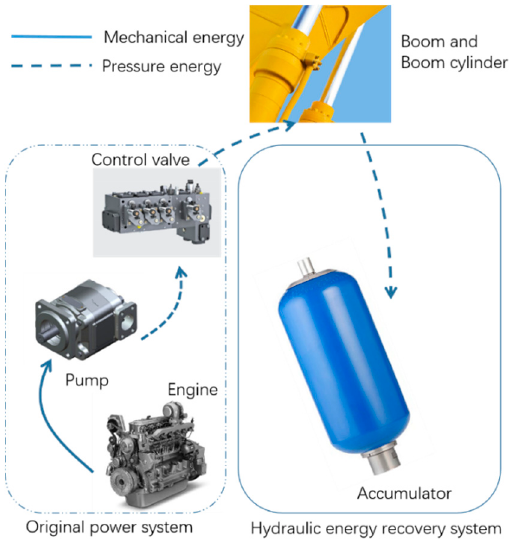
Figure 2. Schematic of hydraulic excavator equipped with the hydraulic energy recovery system.